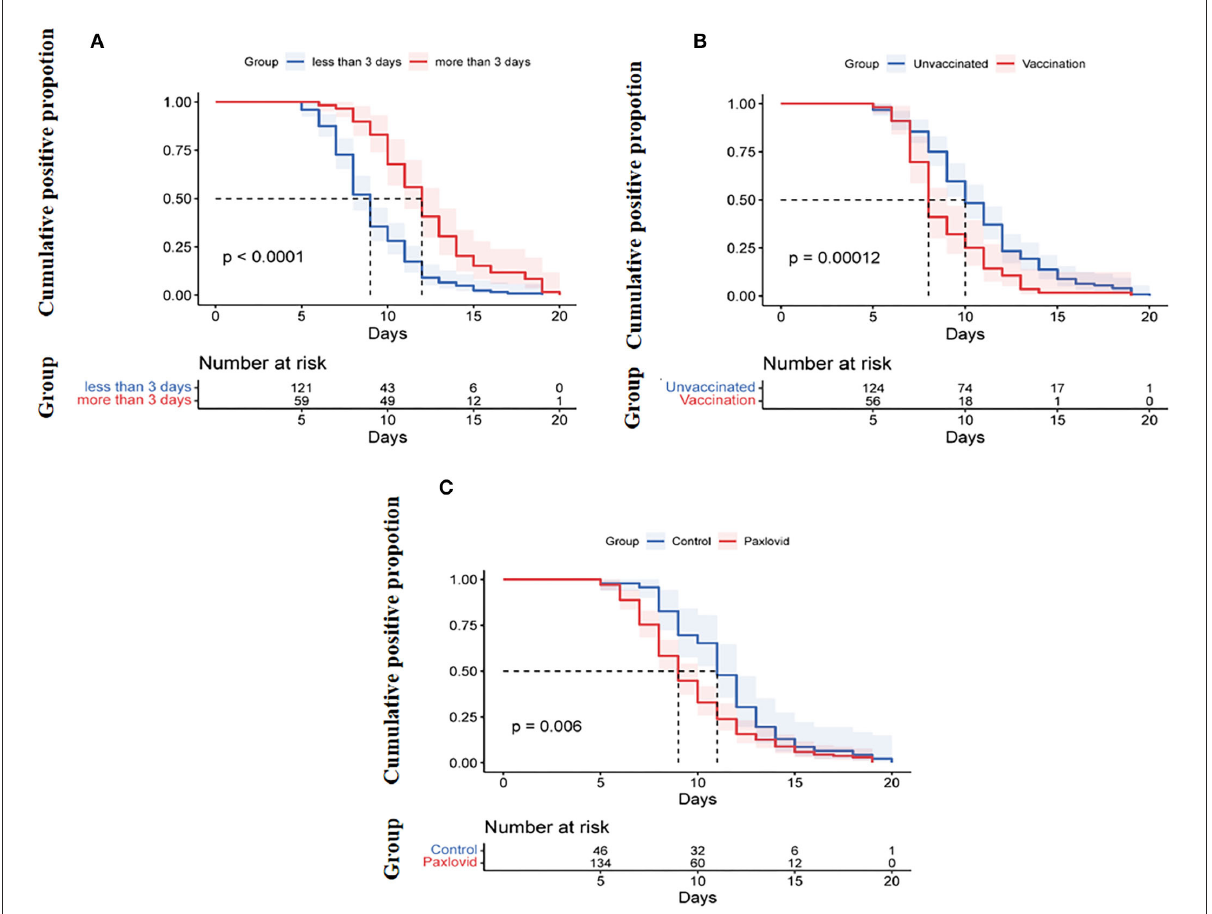
FIGURE2 (A) Cumulative proportion of the nucleic acid shedding after illness onset by age (log-rank p < 0.0001). (B) Cumulative proportion of the nucleic acid shedding after the onset of diagnosis between patients admitted to the hospital < 3 days and those admitted ≥ 3 days after onset of diagnosis (log-rank p = 0.00012). (C) Cumulative proportion of the nucleic acid shedding after illness onset of diagnosis between Paxlovid patients or not (log-rank p =